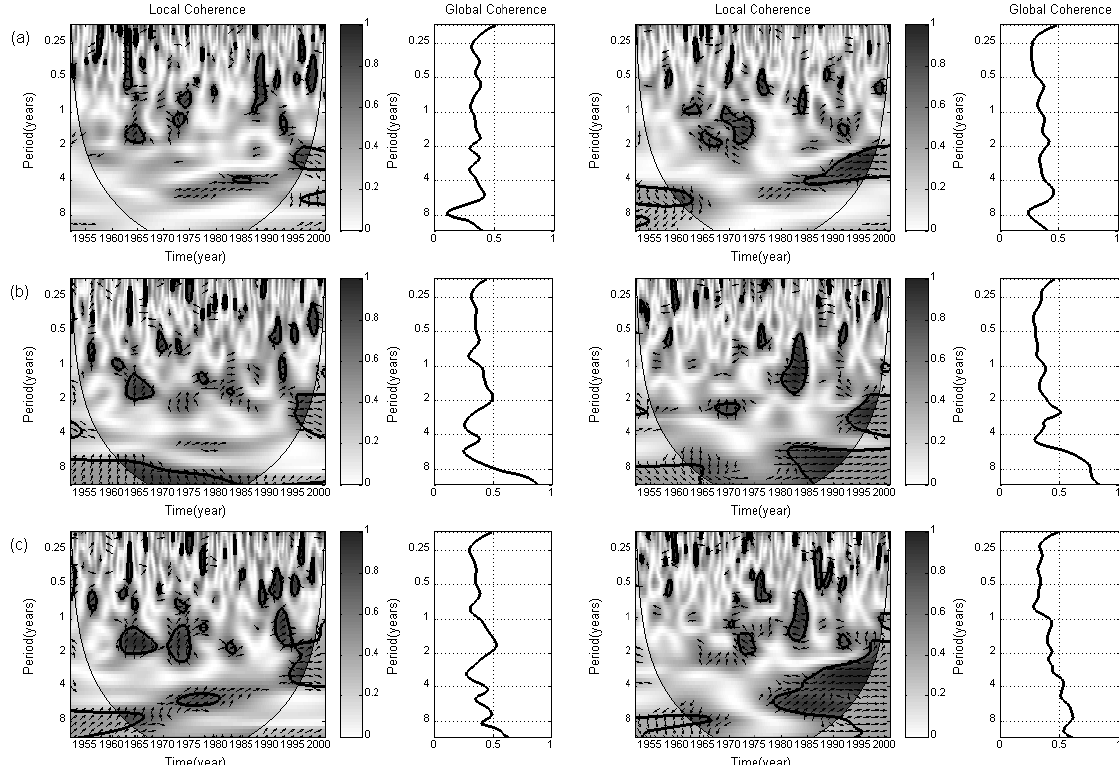
Fig. 9. Same as Fig. 8 but for soil moisture.